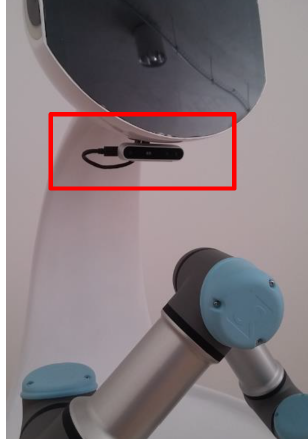
Figure 4. The RGB-D camera used in image acquisition located at a mobile robot